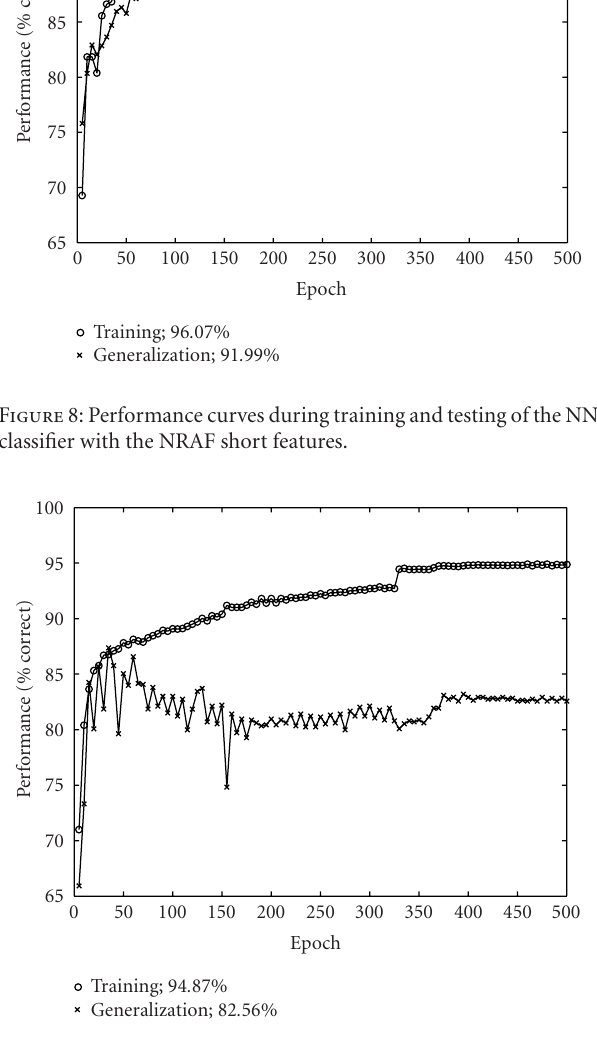
Figure 9: Performance curves during training and testing of the NN classifier with the AM short features.